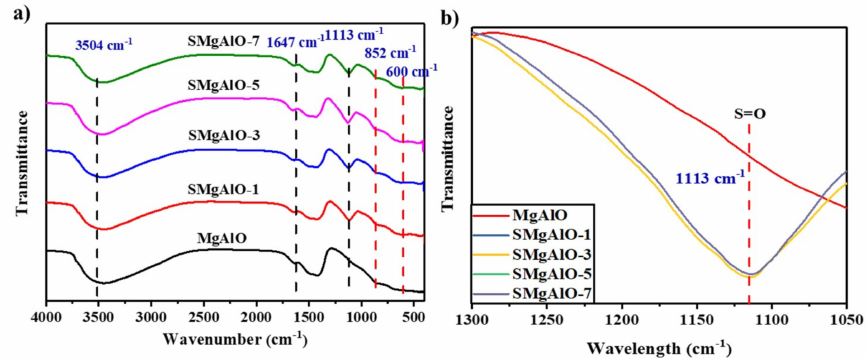
Figure 2. FT-IR spectra of MgAlO and SMgAlO-y ( a ), and the indicated enlarged part from 1050–1300 cm − 1 ( b